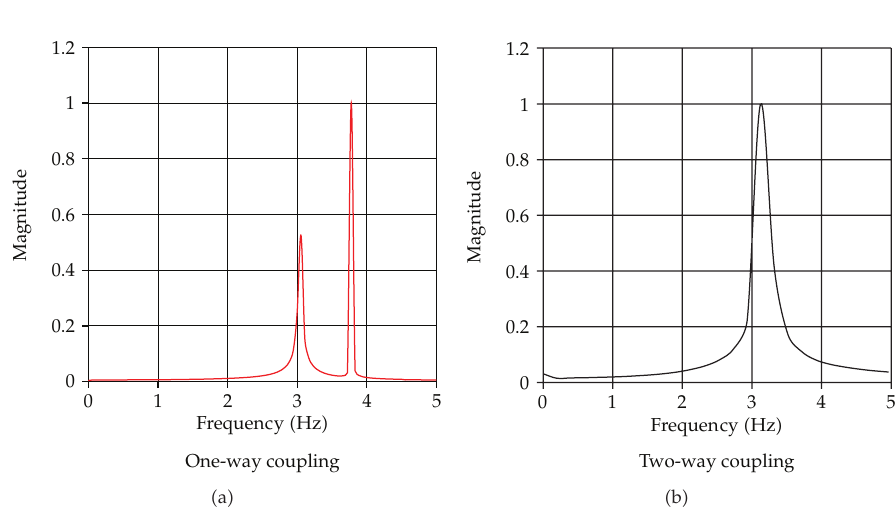
Figure 9: Frequency spectrum, v (cid:8) 0 . 34m/s, plate